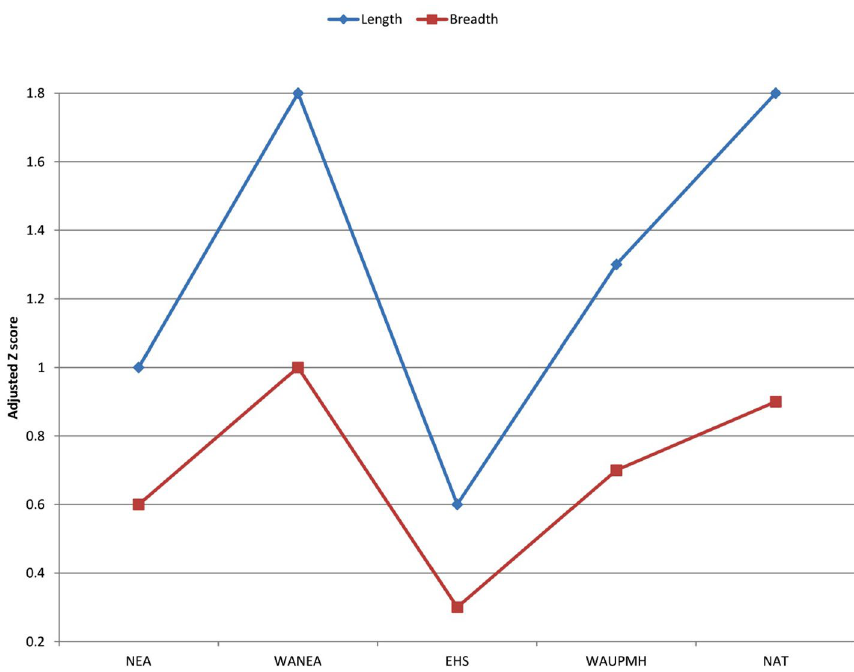
Figure 4. Adjusted Z-scores of the crown dimensions of EM 3869 compared with Pleistocene and Holocene hominins. NEA Neanderthals, WANEA Western Asian Neanderthals, EHS early Homo sapiens , WAUPMH Western Asia Upper Palaeolithic modern humans, NAT